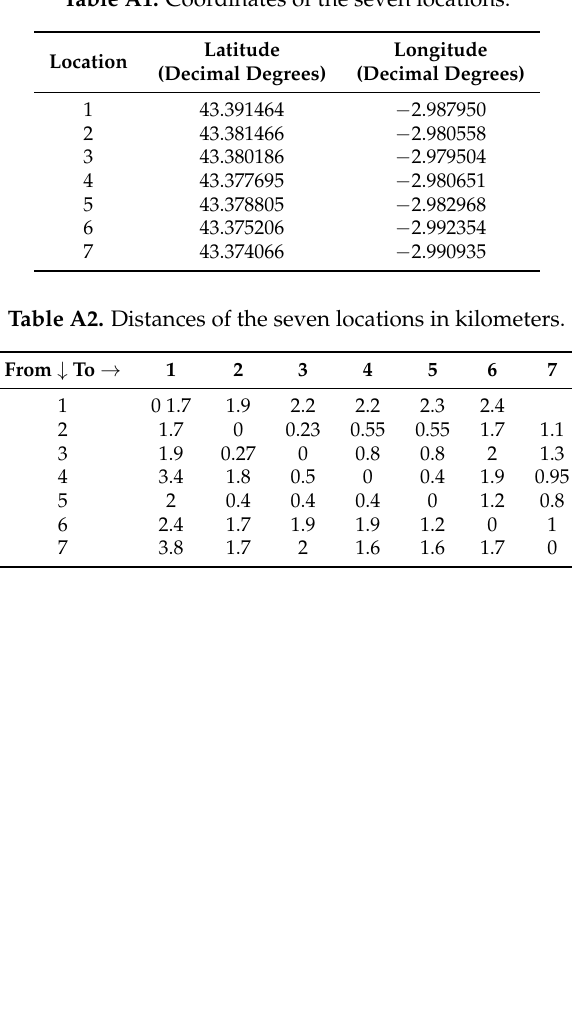
Table A1. Coordinates of the seven locations.